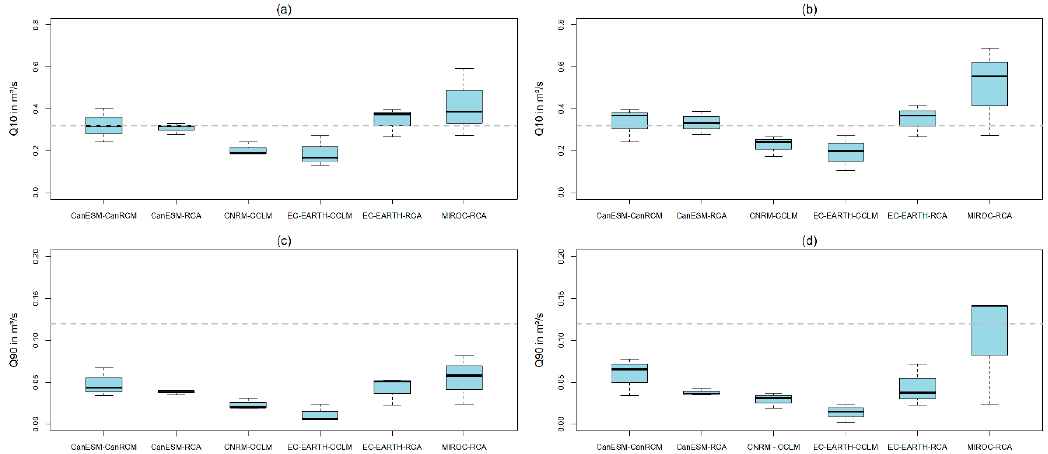
Figure 12. Distribution of Q10 ( a , b ) and Q90 ( c , d ), representing the flow exceeded in 10% or 90% of the time for Q10 and Q90, respectively. a,c represents models runs within the RCP4.5 scenario from 2021 to 2050. b,d represent model results within the RCP8.5 scenario from 2021 to 2050. Dashed grey line in each graph represents modelled historical Q10 and Q90 for the period 1976–2005.